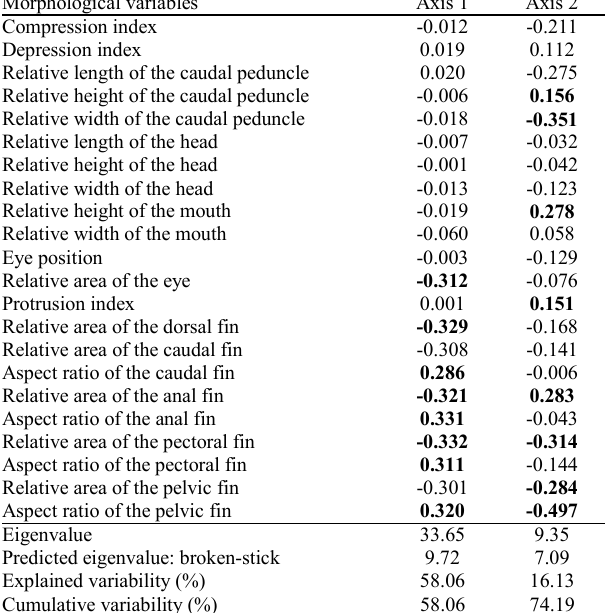
Table 4. Eigenvectors of morphological variables for axes 1 and 2 of the principal components analysis. The eigenvectors with the highest positive and negative values (in bold) were selected to interpret the species ordination in the multivariate morphological space. In the lower portion of the table are listed the eigenvalues and the percentage of variability explained by each principal component. Morphological